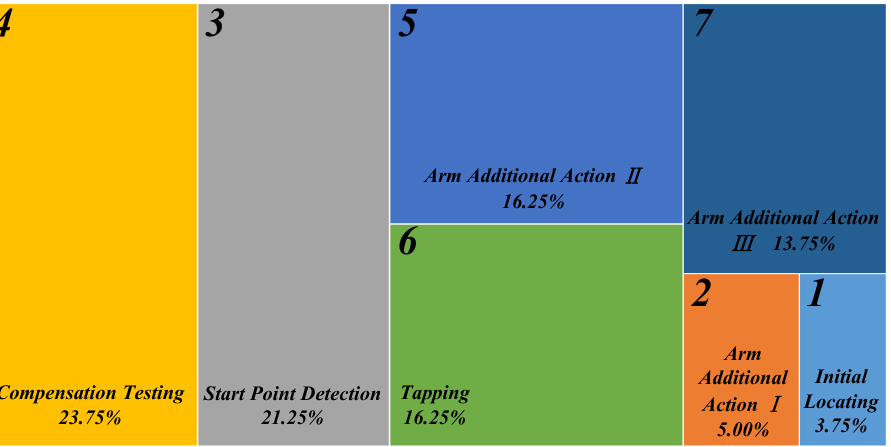
Figure 5. The time percentage of each stage in the cutting process. The more time consumed by one single stage, the larger its rectangular square area will